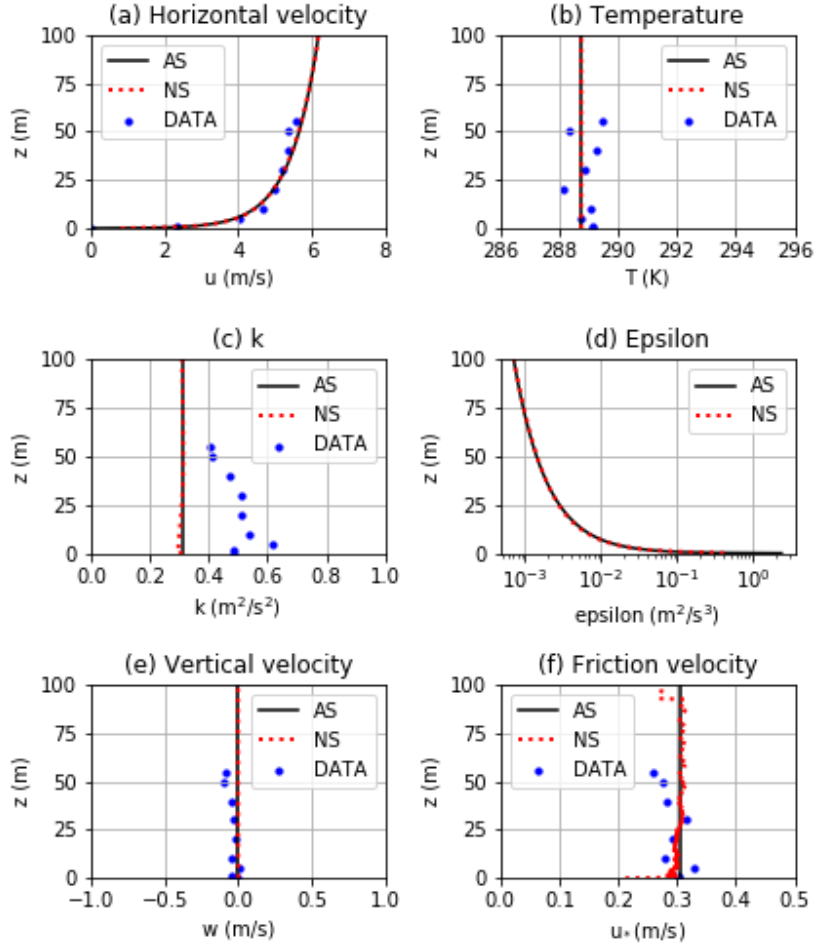
Figure 1. Comparison of the numerical solution (NS) with the analytic solution (AS) for the NBL: ( a ) horizontal velocity, ( b ) potential temperature, ( c ) turbulent kinetic energy, ( d ) turbulence dissi- pation rate, ( e ) vertical velocity, and ( f ) friction velocity. The numerical results are shown for a position 2000 m from the upwind boundary of the domain. The CASES-99 data are also shown, where applicable.